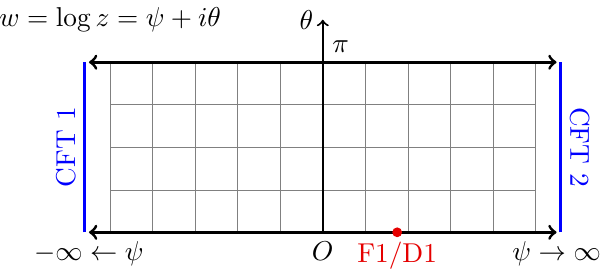
Figure 2 . In strip coordinates w = + i(cid:18) the two asymptotic regions, depicted by blue bars, lie at ! (cid:6)1 . Each harbors a CFT which di(cid:11)er due to the presence of the F1/D1 defect located